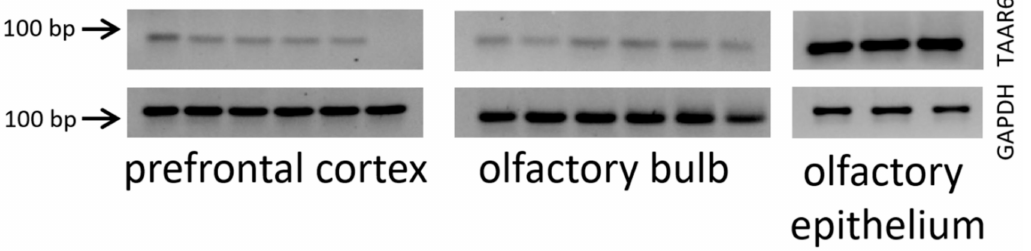
Figure 7. Reverse transcription-polymerase chain reaction (RT-PCR) with TAAR6- and GAPDH (housekeeping gene)-specific primers using RNA isolated from the mouse main olfactory epithelium, olfactory bulb, and prefrontal cortex confirmed TAAR6 expression in the prefrontal cortex. These gel images are cropped, and full-length images are presented in Supplementary Figure